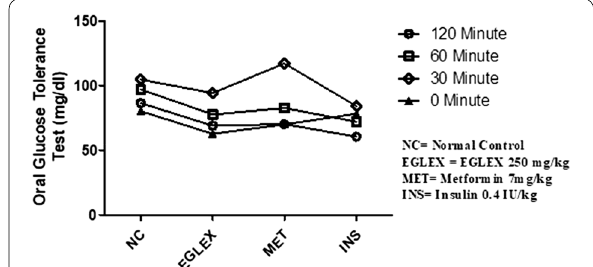
Fig. 8 Oral Glucose Tolerance Test in Control and Pre-treated